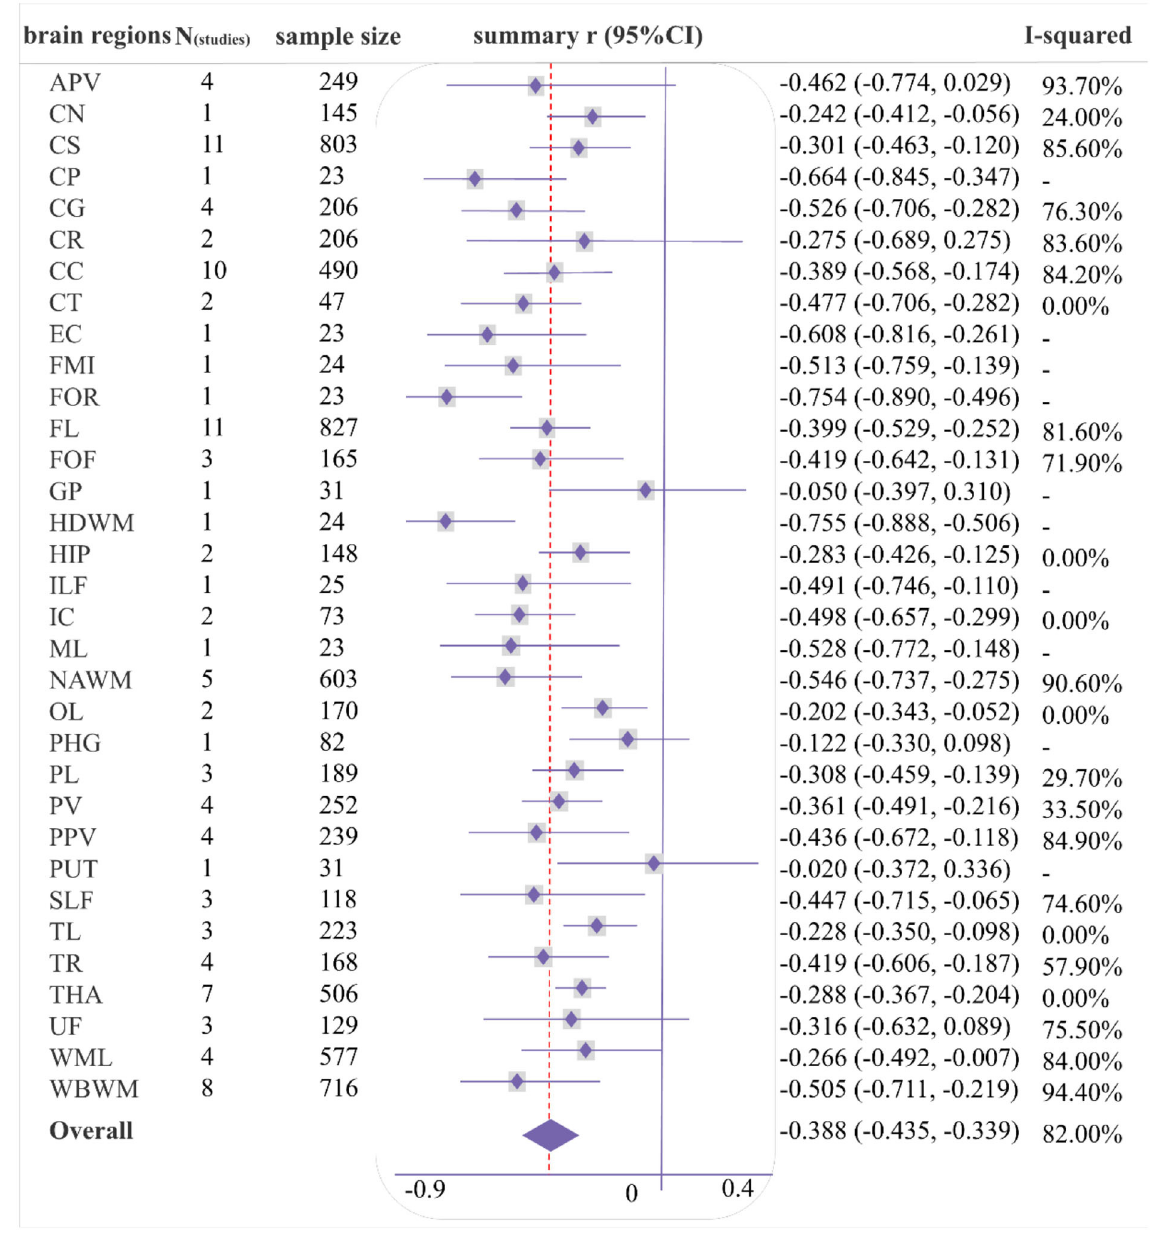
FIGURE4 Forest plot of correlations between mean diffusivity/apparent diffusion coefficient (MD/ADC) and general cognition by different brain regions.